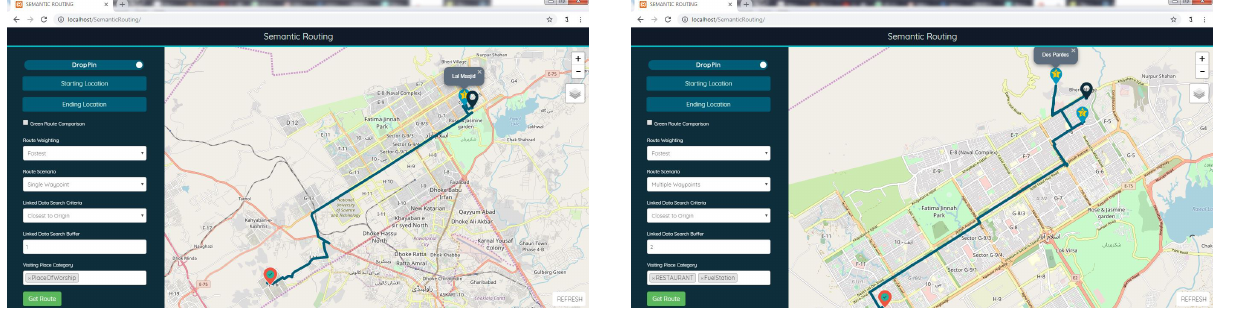
Figure 10. Routing through the waypoint closest to route origin that goes through the closest to origin waypoint and displays the route on map.